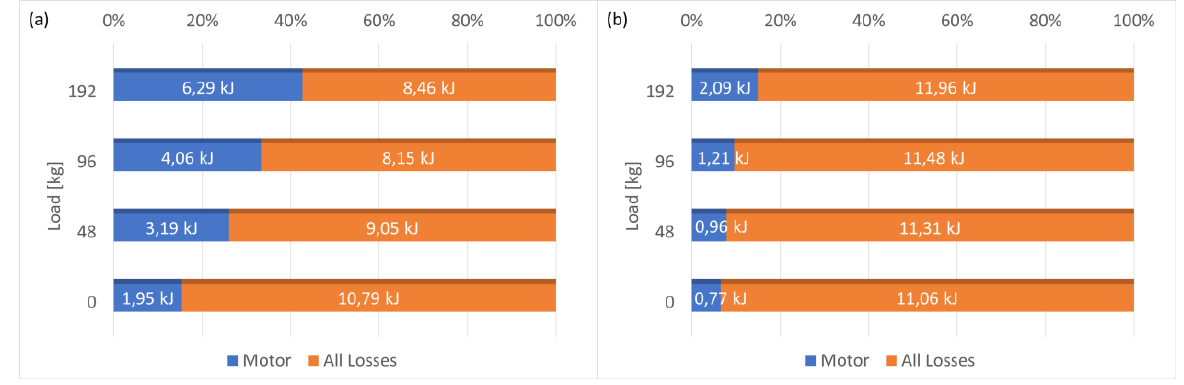
Figure 8. Motor vs. all losses: ( a ) conventional drive, ( b )